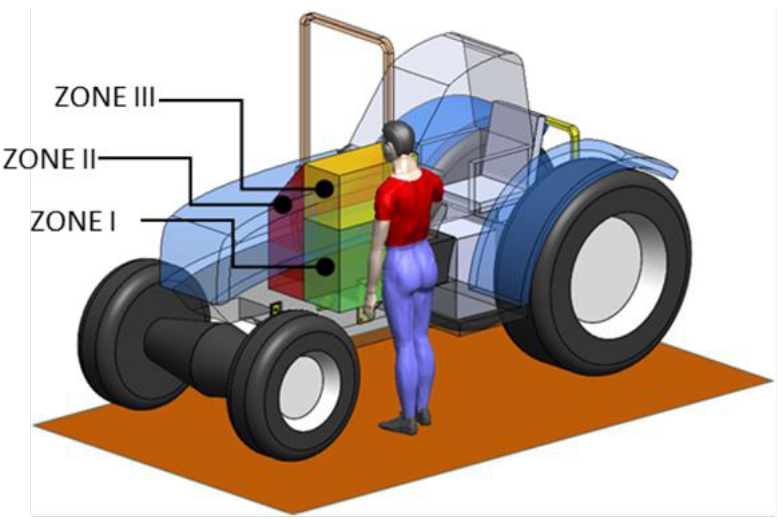
Figure 3. Accessible zones of the grasping area for a wheeled tractor according to OECD Code 6 criteria.